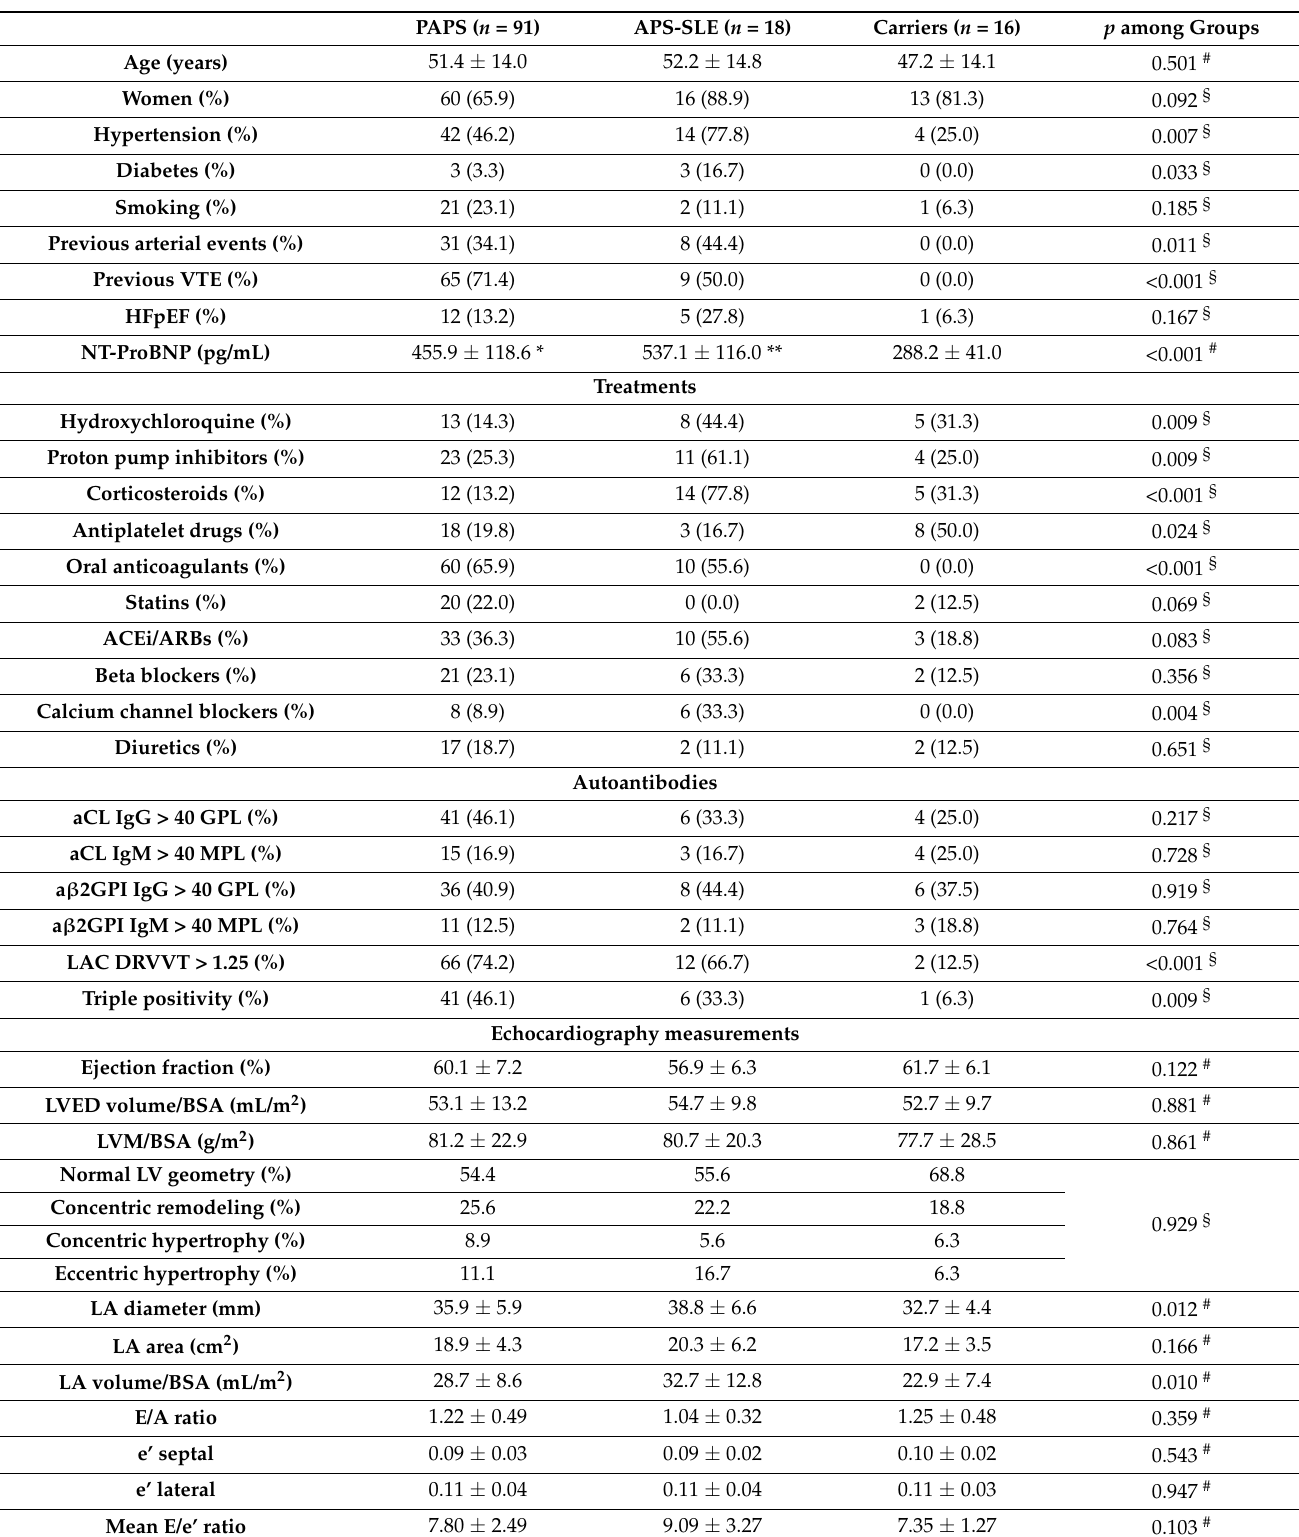
Table 1. Characteristics of patients according to aPL